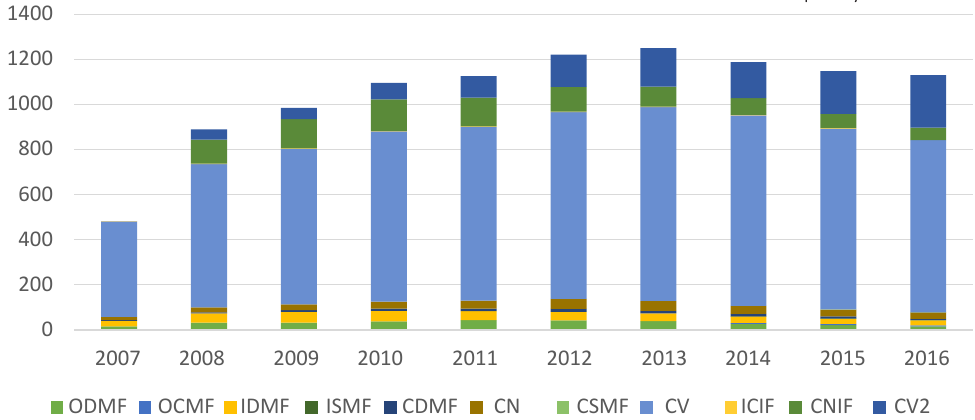
Figure 6. Dynamics of the number of ICI in Ukraine for 2007–2016 in terms of types,